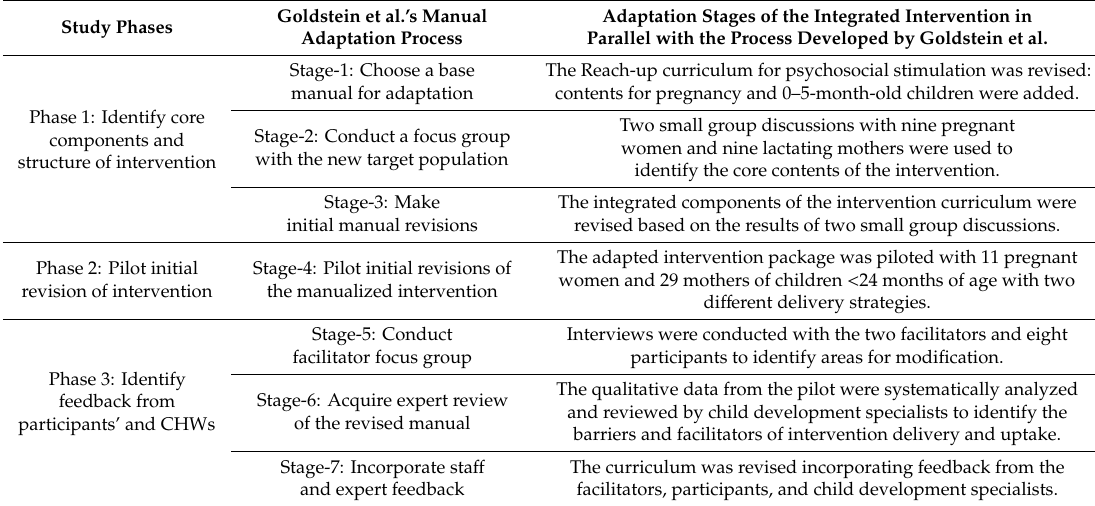
Table 1. Adaptation phases of integrated